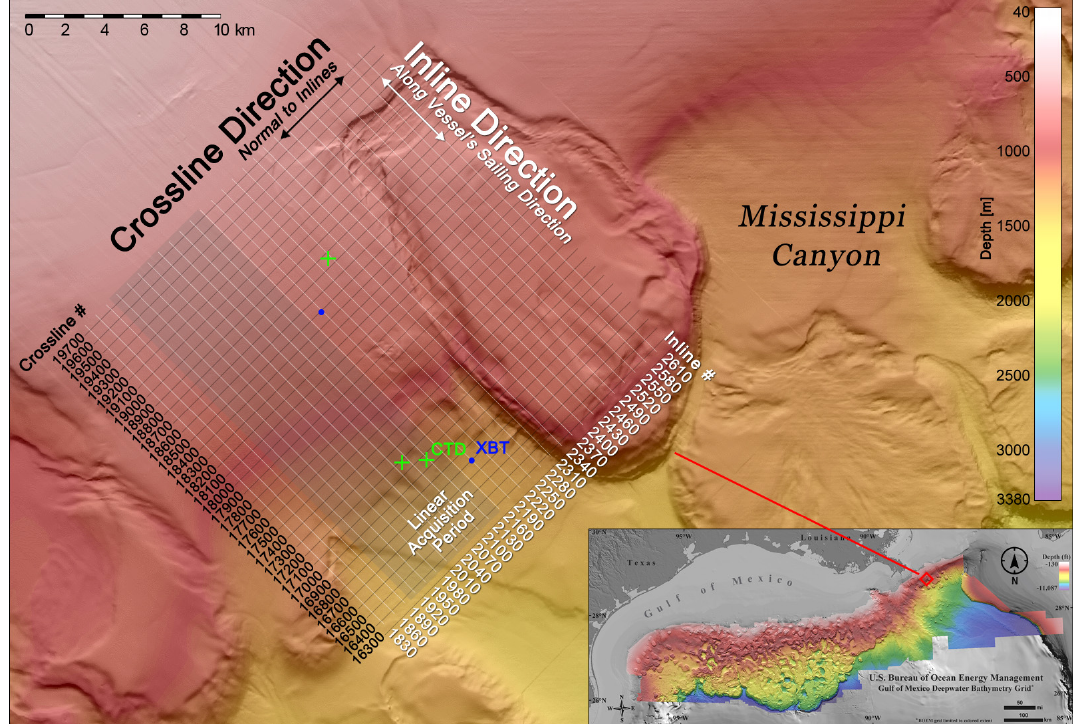
Figure 1. 3D seismic survey area with inline (white) and crossline (black) configuration, CTD (green cross) and XBT (blue dots) locations, and seafloor topography (background color). The 3D seismic survey area is marked by the grids. Inline is oriented to go down the continental slope. The inset shows the survey location in the northern Gulf of Mexico. The seafloor topography data are provided by Bureau of Ocean Energy Management. The gray grids mark the linear acquisition period (explained in Sect.